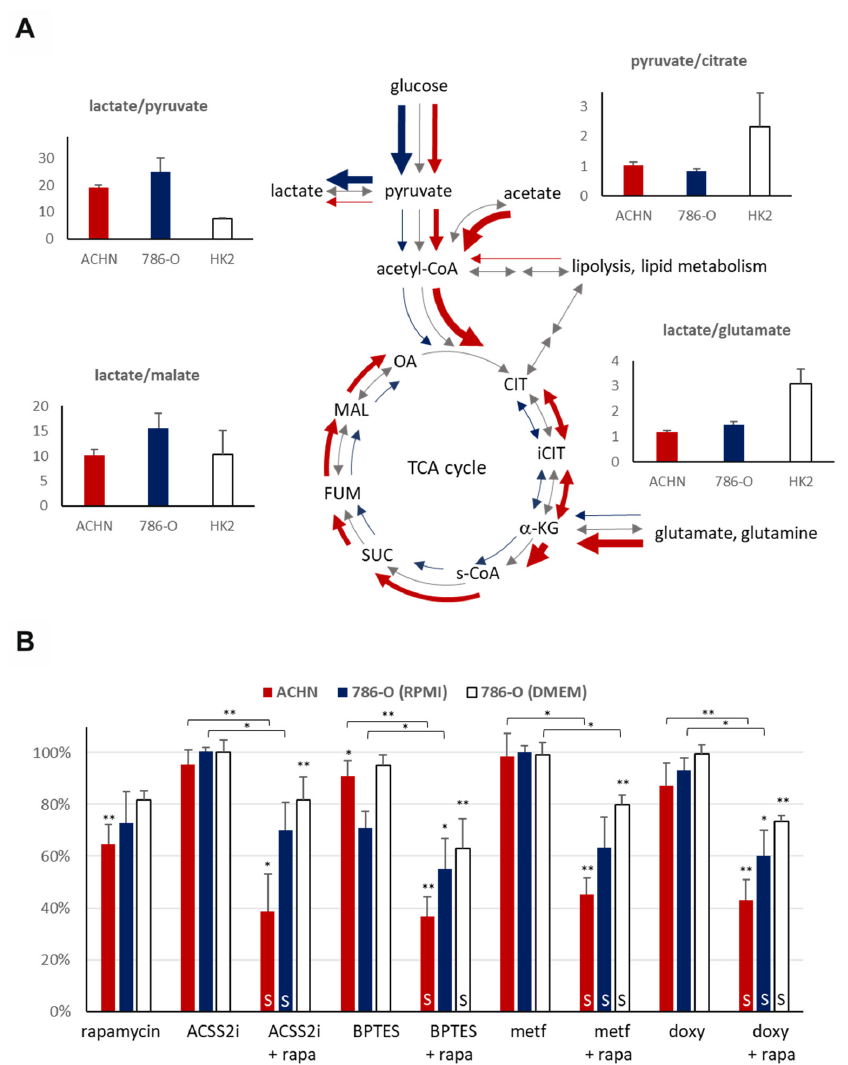
Figure 5. LC–MS analyses of metabolic features and inhibitor sensitivity of papillary (ACHN) and clear cell renal cell carcinoma (786-O) cell lines. ( A ) LC–MS analysis of the intracellular metabolite concentrations in papillary (ACHN), clear cell (786-O) RCC and normal tubular epithelial (HK-2) cell lines. Lactate/pyruvate, pyruvate/citrate, and lactate/malate ratios were used to assess the glycolytic capacity and the activity of the TCA cycle of the cell lines (CIT–citrate, iCIT–isocitrate, α -KG–alpha-ketoglutarate, s-CoA–succinyl-CoA, SUC–succinate, FUM–fumarate, MAL–malate, OA–oxaloacetate), whereas lactate/glutamate ratio was used to evaluate the glutamine utilization. ( B ) The mTORC1 (rapamycin–rapa) and metabolic inhibitors (ACSS2i–inhibitor of acetate utilization, BPTES–glutaminolysis inhibitor, metformin–metf–AMPK-inhibitor, doxycycline–doxy–antibiotics with mitochondrial inhibitory effect) sensitivity of papillary (ACHN) and clear cell (786-O) RCC cell lines were evaluated as monotherapy or in combination. Regarding the 786-O cells, the treatments were performed both in RPMI-1640 (2000 mg/L glucose) medium under generally applied and optimized conditions and in DMEM high glucose (4500 mg/L)–to compare the role of maintaining parameters with similar glucose concentration levels as ACHN and HK-2 cells. * p values below 0.05, ** p values below 0.01 (one-way ANOVA with Tukey’s post hoc test), and at least 20% decrease in proliferation were considered biologically relevant. Synergistic treatment interactions were labeled with S (based on combination index